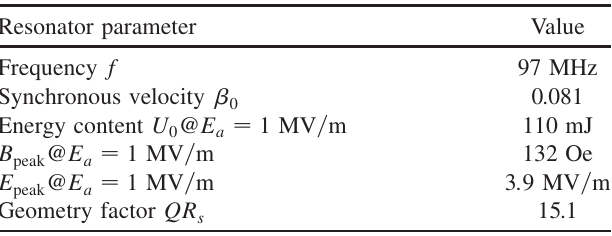
TABLE I. Relevant parameters of the quarter wave resonator used in the superconducting linac at IUAC.